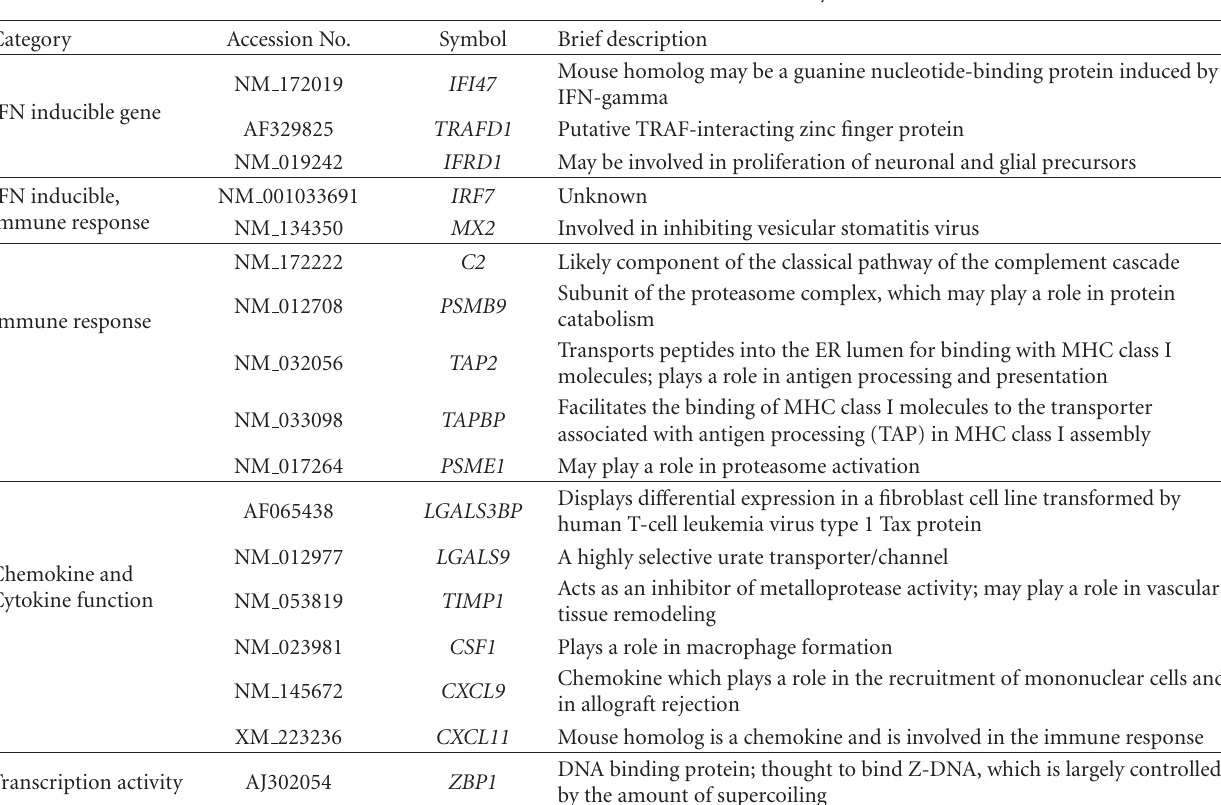
Table 2: Biomarkers for influenza vaccine